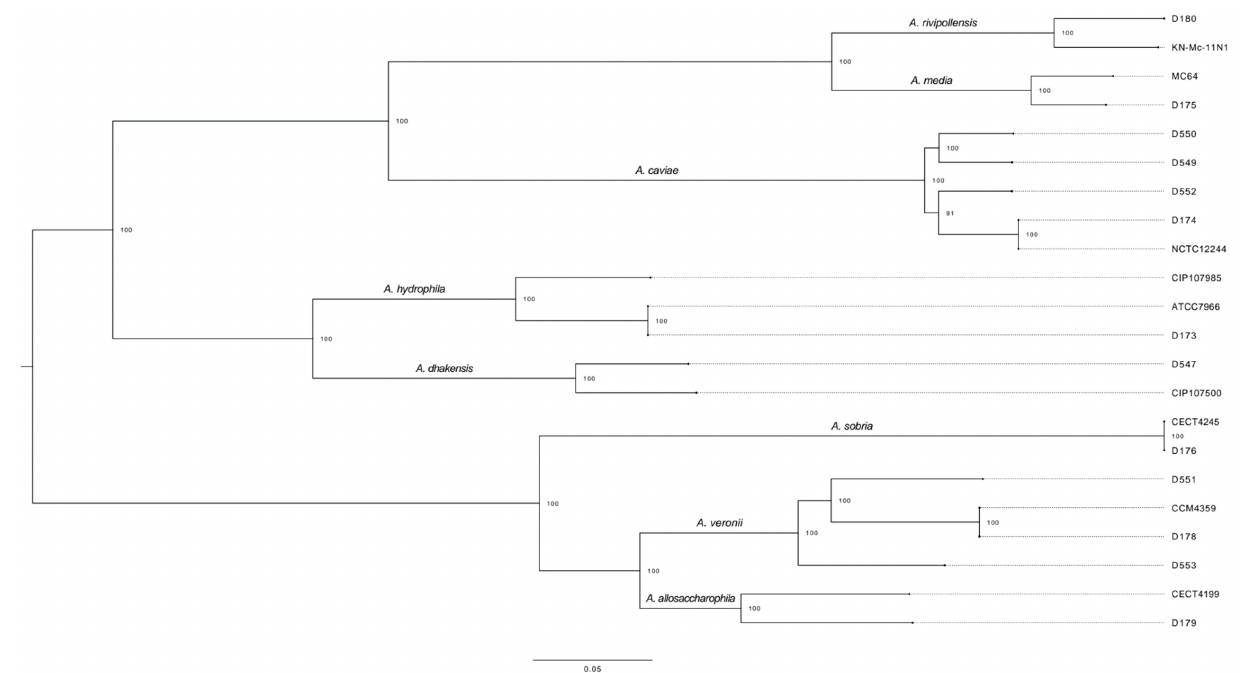
Figure 1. Maximum likelihood phylogenetic tree derived from the core-genome alignment of the Aeromonas spp. isolates and type strain genomes. All strains with names beginning with D are isolates from the laboratory. Bootstrap values above 80% are shown in branch nodes (premutation = 100). The different clusters within the phylogenetic tree contain previously identified sequences posted on GenBank. Type strain information and accession numbers are presented in Table S1. Table 2. Antimicrobial susceptibility test results for the 13 Aeromonas